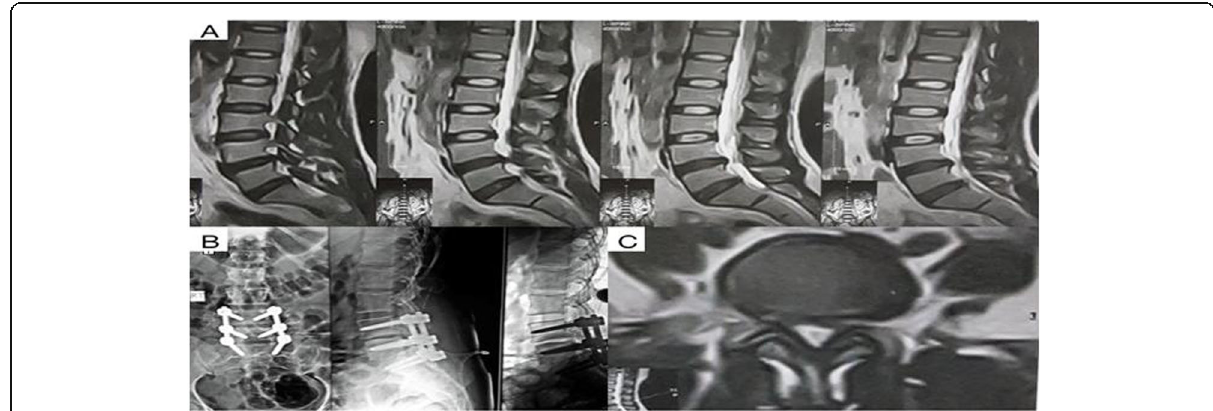
Fig. 4 Sagittal and axial T2WI MRI images are showing multiple level discogenic with ligamentum stenosis and spinal stenosis ( a and c ). PO radiograph (AP and lateral views) showed double levels of conventional laminectomy with fusion